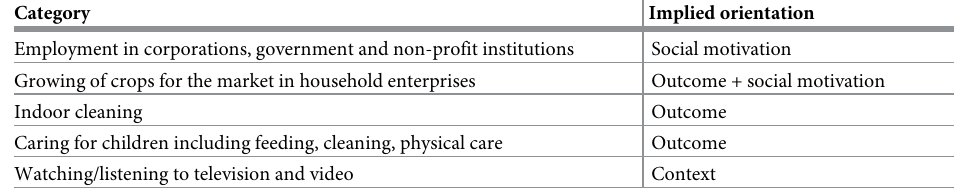
Table 1. Inconsistent theoretical orientations of categories in an existing lexicon. Five examples are drawn from the International Classification of Activities for Time Use Statistics (ICATUS). For each, we indicate the implied theoreti- cal